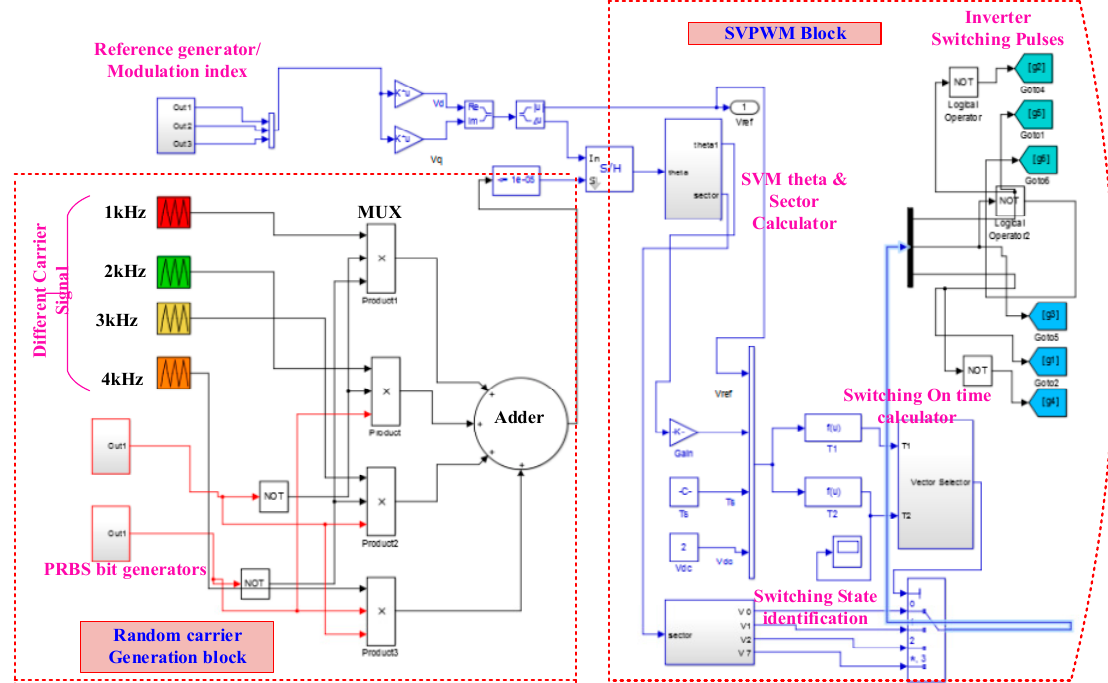
Figure 6. MATLAB simulation model for the MCRSVPWM.